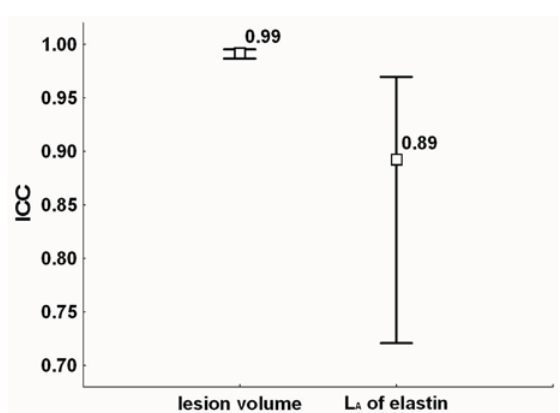
Figure 5. Intraclass correlation coefficients (ICC). The variability among three independent observers in estimates of lesion volume and of length density of elastin network. Values are ICC and lower-upper limits of the 95% confidence